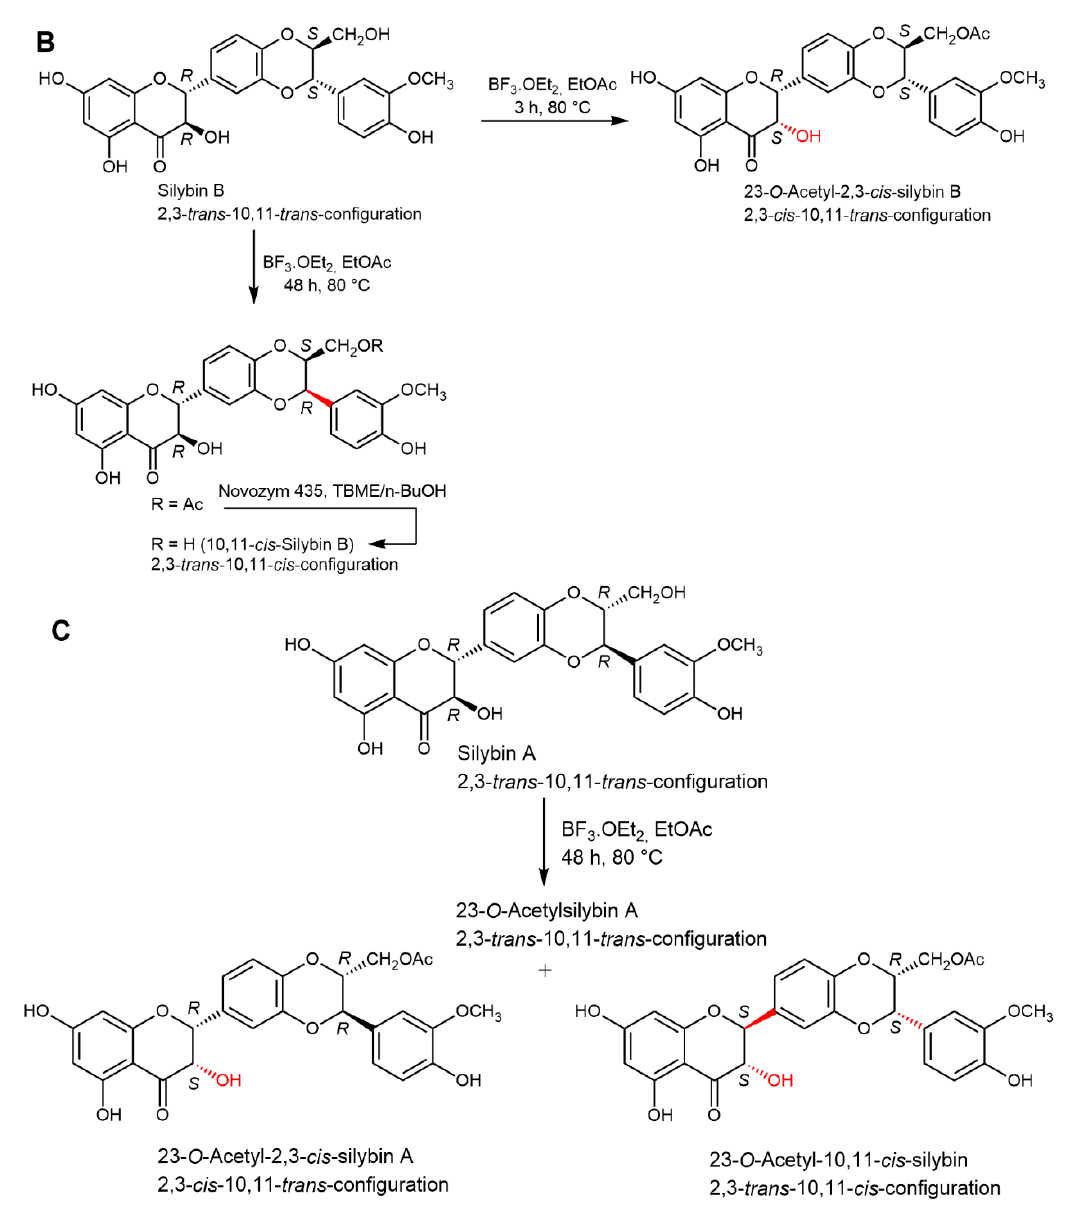
Figure 5. cis-trans Isomerizations of the optically pure silybins [25]. ( A ) Silybin A and silybin B isomerizations into respective 2,3- cis -isomers (DMF, dimethylformamide). ( B ) Silybin B isomerization in EtOAc (TBME, tert -butyl methyl ether). ( C ) Isomerization of silybin A in EtOAc.